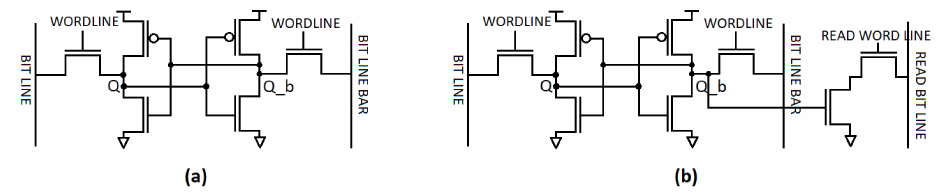
Figure 1. Conventional state-of-the-art SRAM cell structure: ( a ) 6T; and ( b ) 8T (Source [3]).